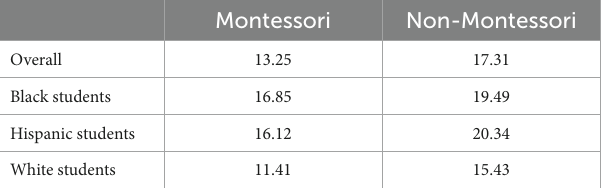
TABLE 2 Average percent of chronically absent students by school type.